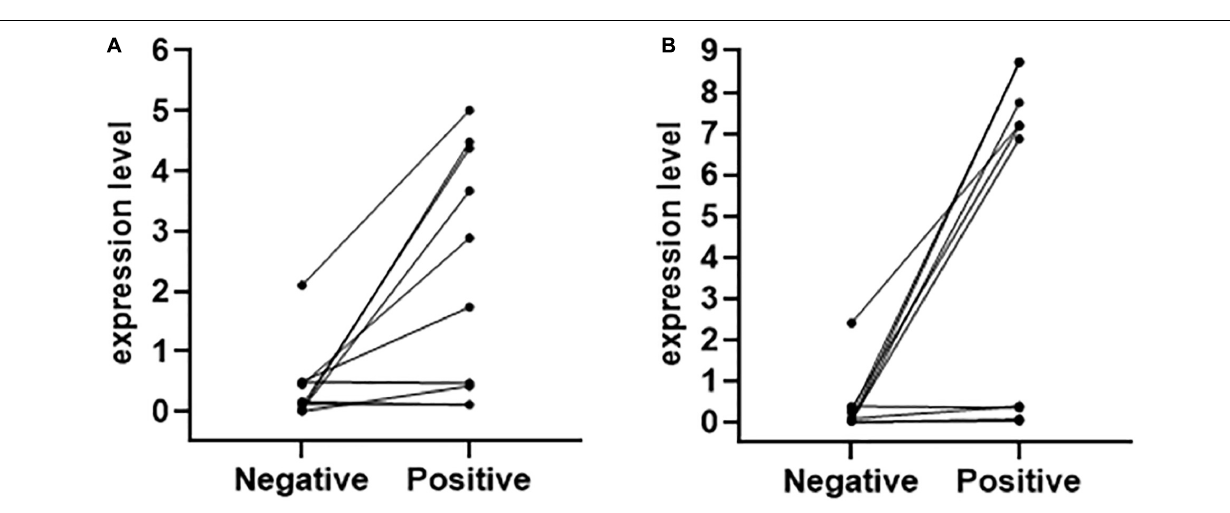
FIGURE 4 | The expression level (pmol per 1L serum) of ASdes (A) and MTB-miR5 (B) in the small extracellular vesicles derived from serum of TB infection patients with negative AFB smear staining and sputum culture at the first admission to the hospital (negative) and the second day after the result of AFB smear staining or/and sputum culture changed positive